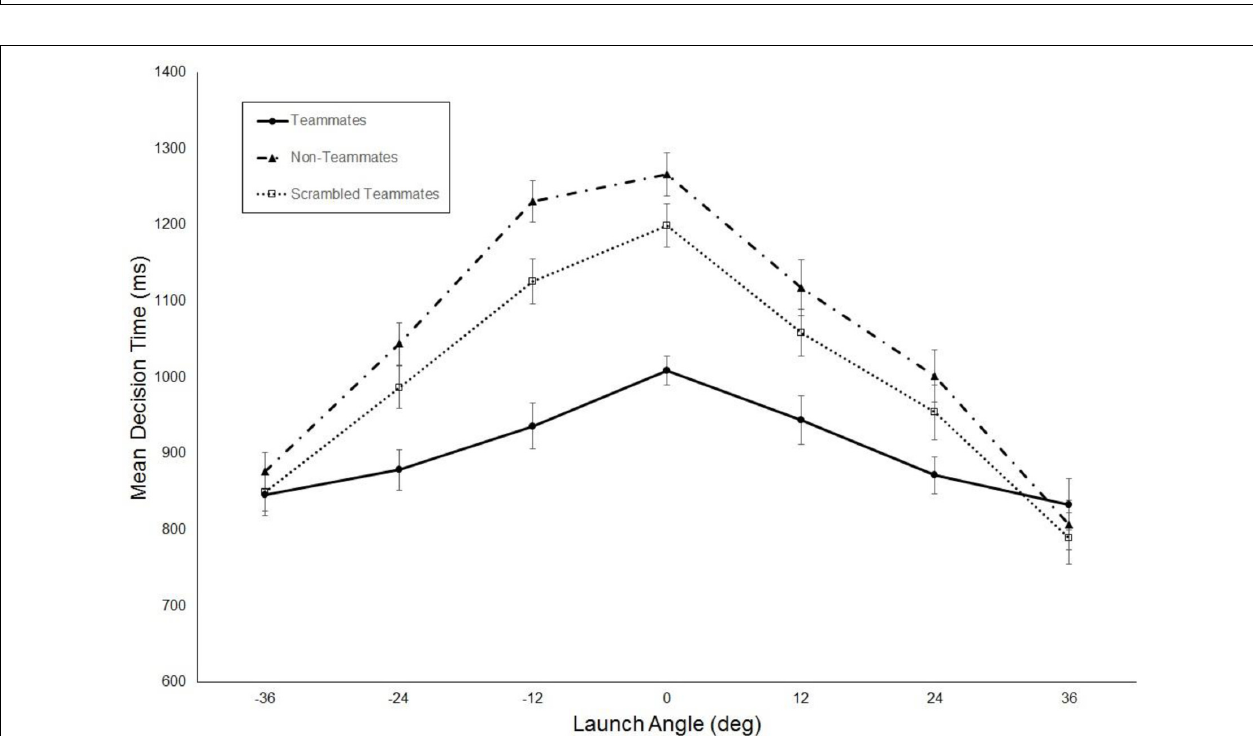
FIGURE 3 | Mean coordination scores plotted as a function of ball launch angle. Error bars are standard errors.